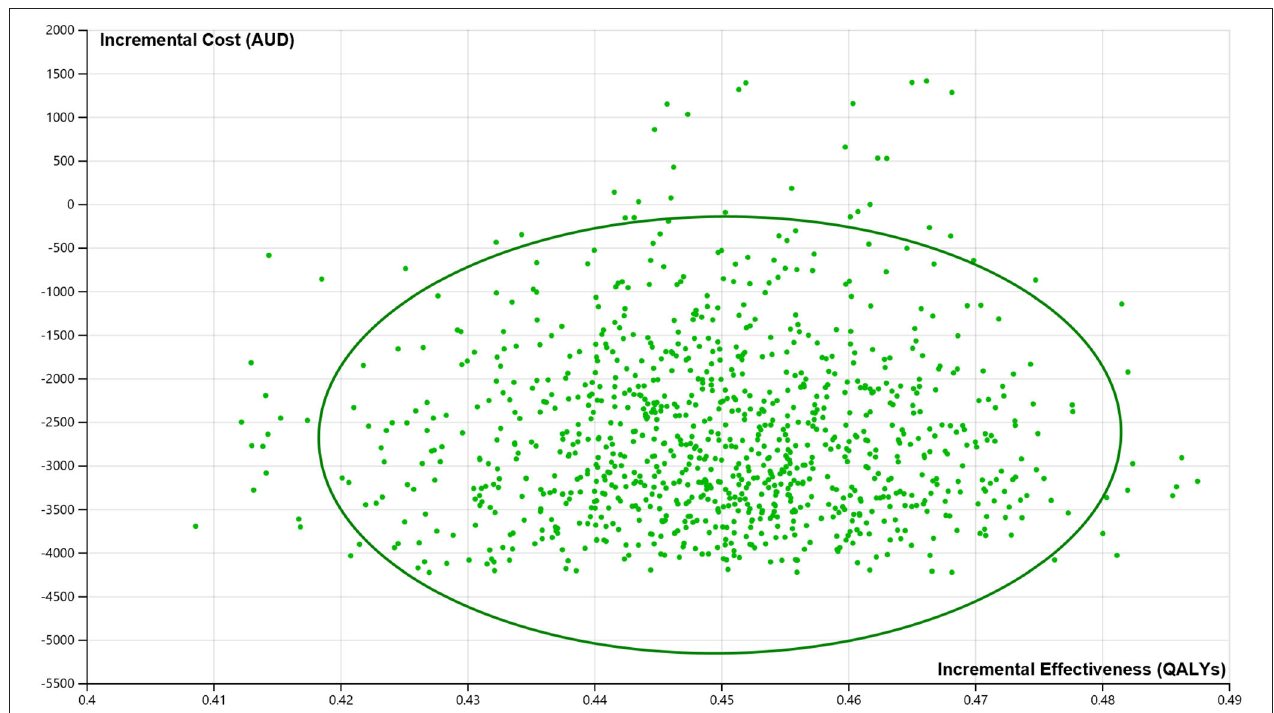
FIGURE 3 | Incremental cost-effectiveness plane from the probabilistic sensitivity analysis. AUDs, Australian dollars; QALYs, quality-adjusted life years. 100% of all the iterations suggest that the stroke telemedicine program is cost saving and more effective over the lifetime of patients.